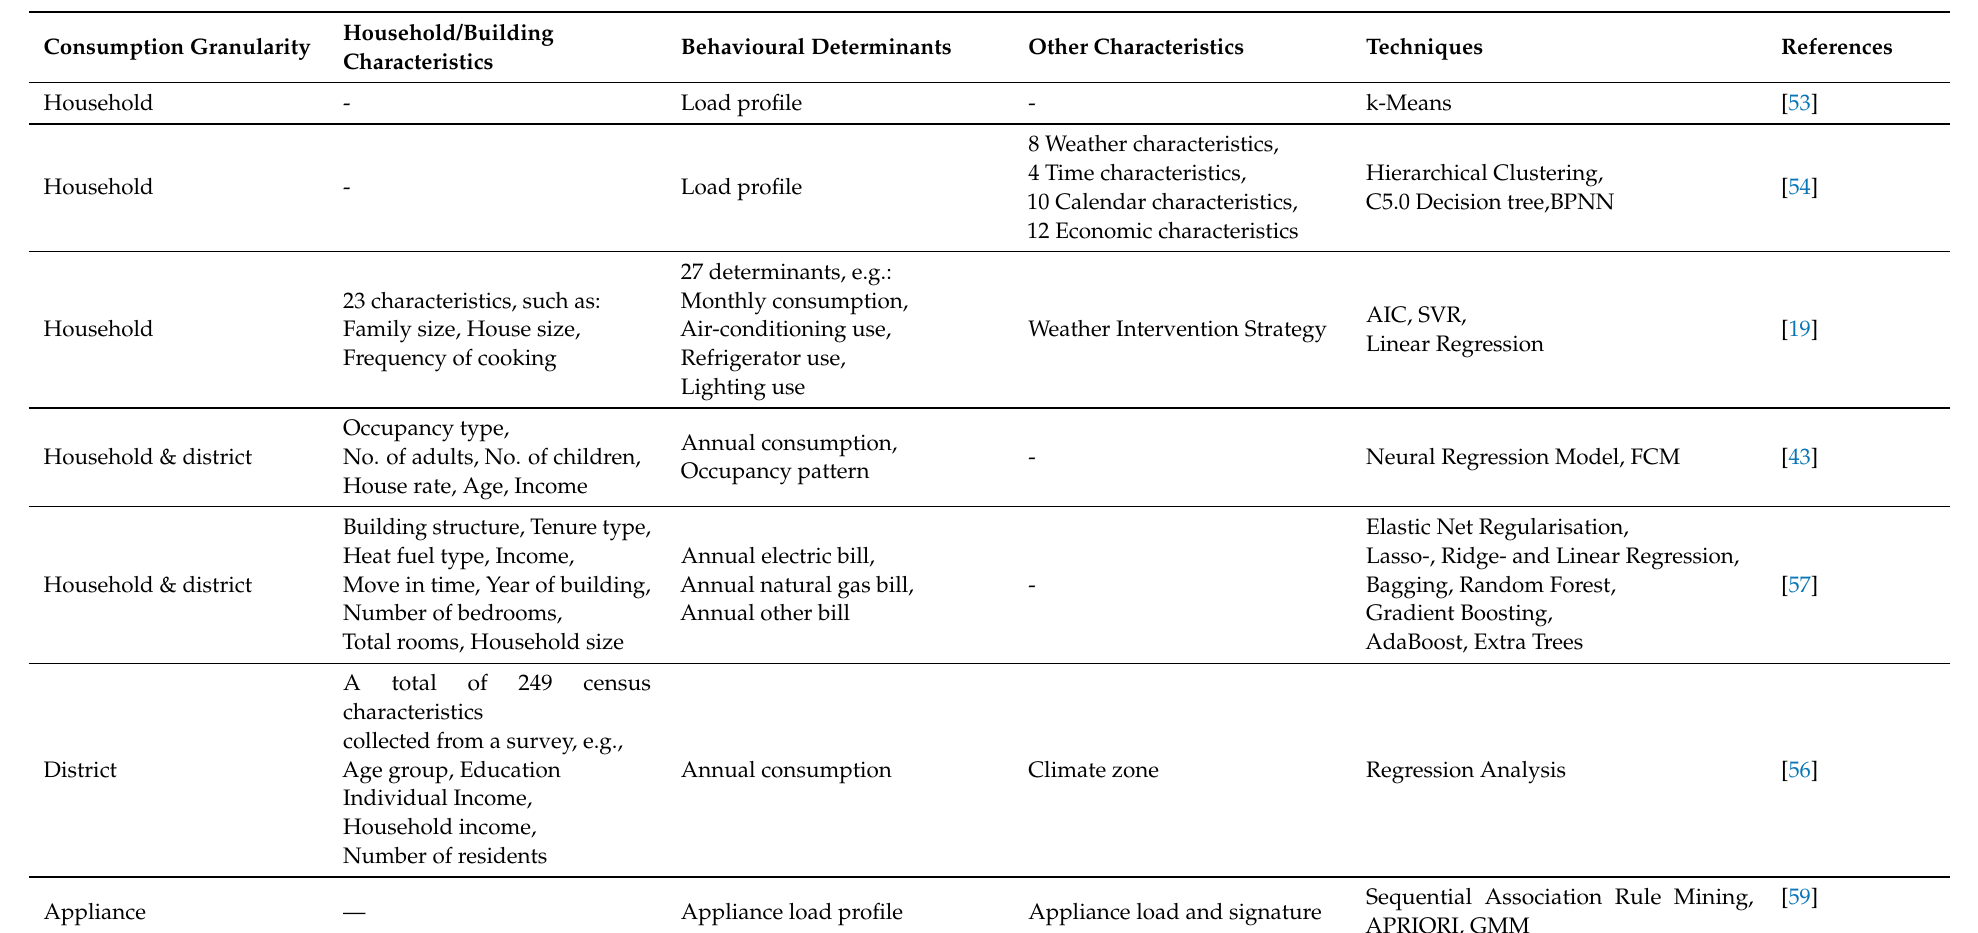
Table 2. A summary of load forecasting additional research works considering